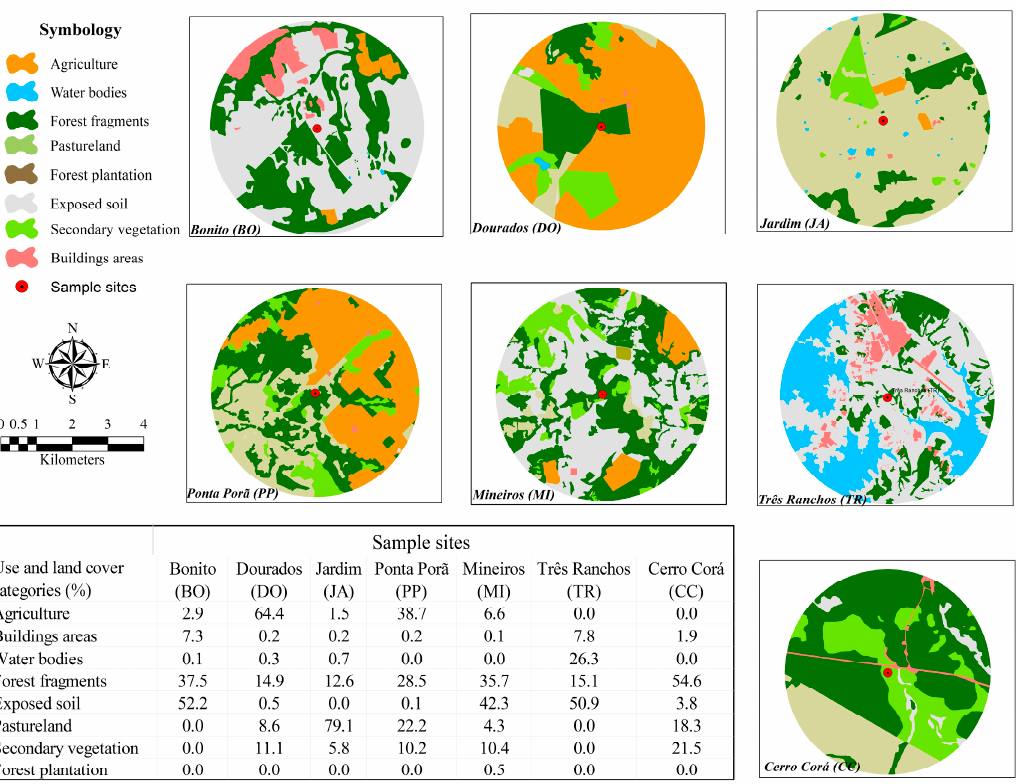
Figure 4. Spatial distributions showing land and use coverage of each sample sites and the percentages of each category of land occupation from the Campomanesia adamantium sample sites.